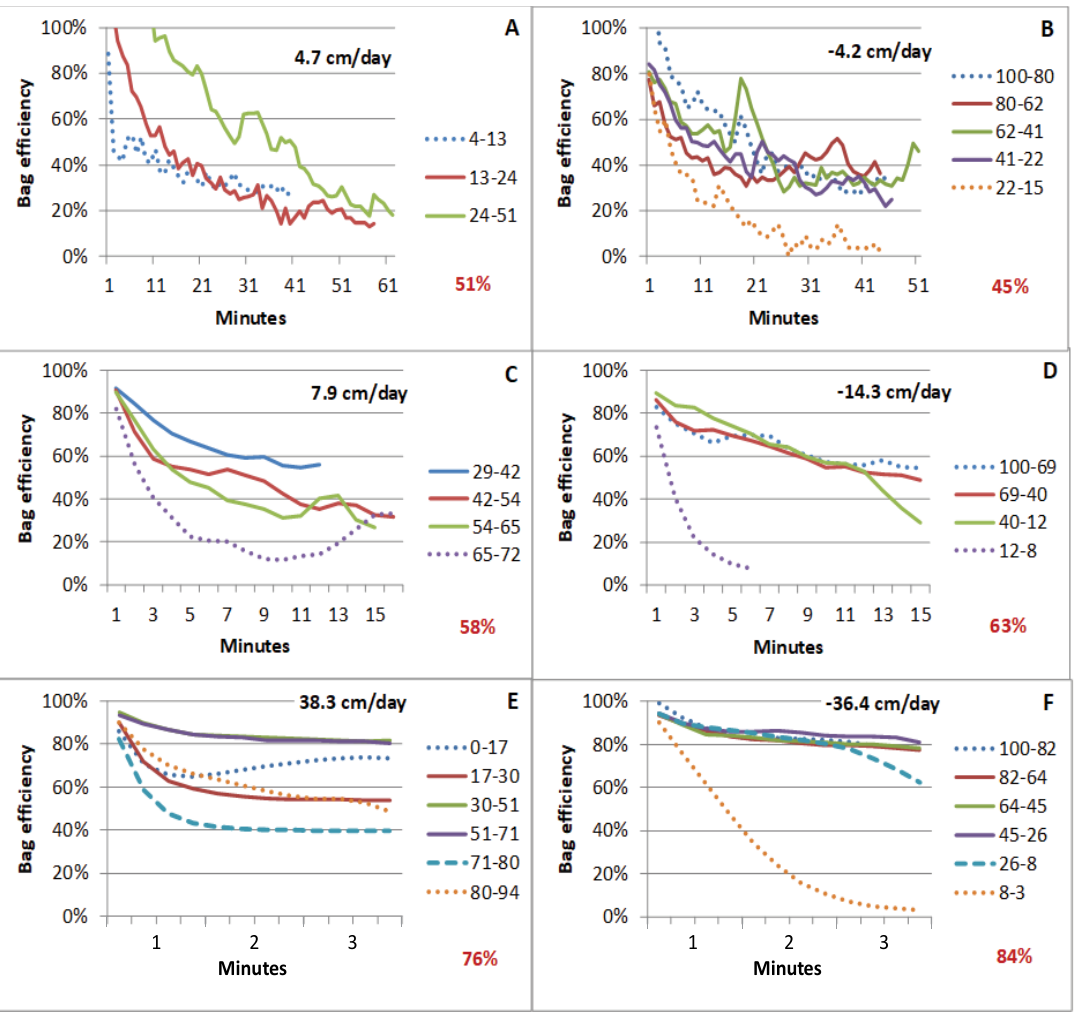
Figure 6. Seepage bag efficiency for upward versus downward seepage. Panels ( A,C,E ) show upward seepage at slow, moderate, and fast seepage rates, respectively. Panels ( B,D,F ) show downward seepage at slow, moderate, and fast seepage rates, respectively. Legend entries indicate beginning and ending percent bag fullness. Values in bold in each chart are seepage rates through the ESM (cm/d) in between bag attachments. Percentages indicated in red are average bag efficiencies for bag tests when bag fullness was within the recommended operating range.